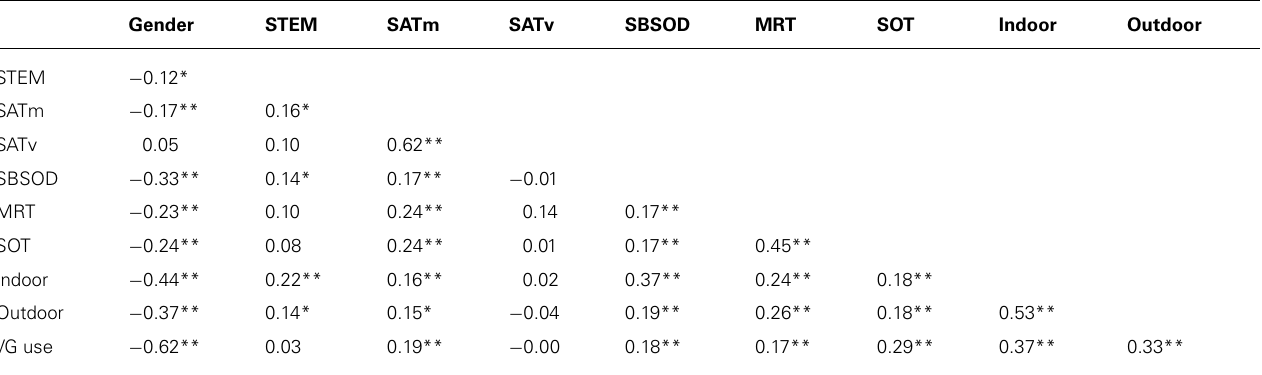
Table 2 | Correlations ( r ) among gender, STEM major, SAT, spatial measures, and video game experience.